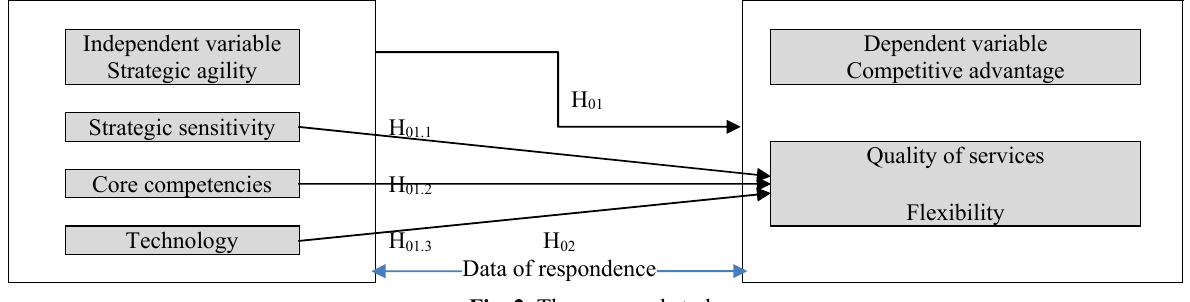
Fig. 2. The proposed